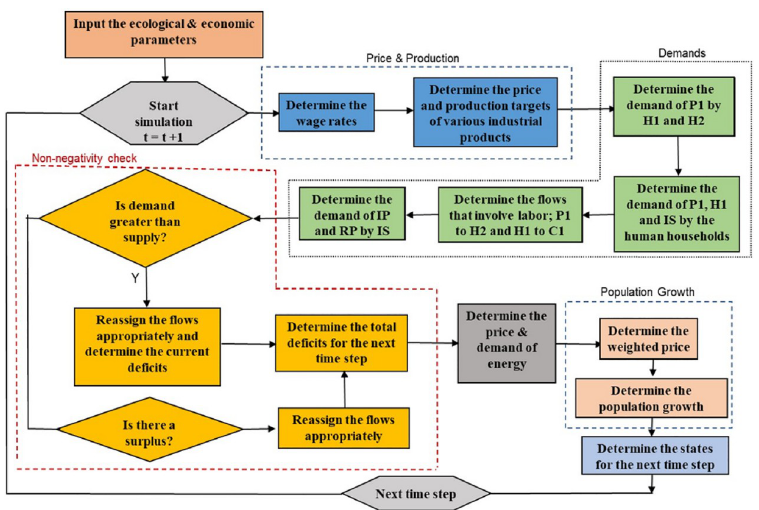
Fig 2. Macro economic model. Boxes with colors indicate- dark blue: step to determine wage rate, price of industry products and production targets. green: step to calculate demands of industrial products by various compartments. yellow: intermediate steps to supply appropriate amount of material to the compartments. orange: calculate population growth. Reproduced from [17].